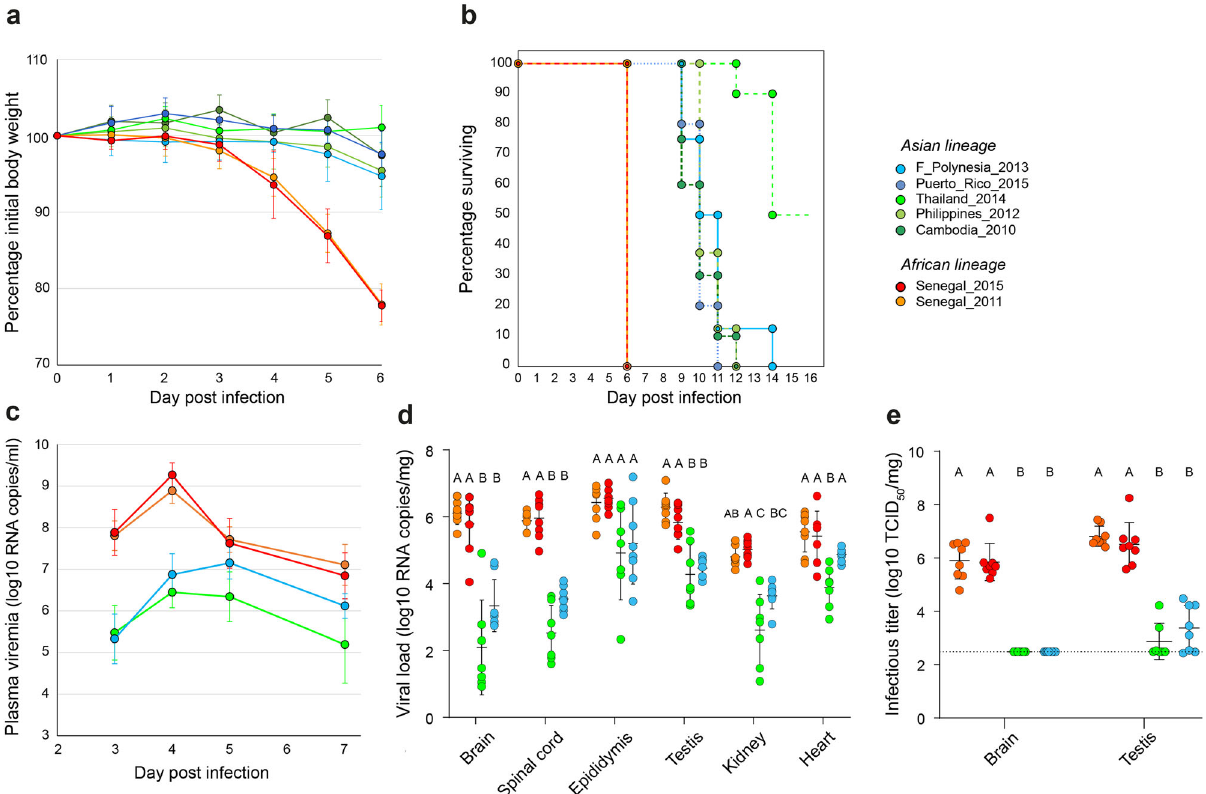
Fig. 4 Pathogenicity of African and Asian ZIKV strains in immunocompromised adult mice. In a fi rst experiment ( a , b ), male AG129 mice were inoculated with 10 3 PFU of ZIKV. Each virus strain was represented by n = 10 mice, with the exception of the F_Polynesia_2013 and Philippines_2012 strains that were represented by n = 8 mice. a Mouse weight over time is shown as the percentage of body weight prior to infection (mean ± standard error). b Mouse survival over time is shown as the percentage of mice alive. Mice were euthanized when reaching humane endpoints (weight loss >20% or/and severe symptom onset). In a second experiment ( c – e ), male AG129 mice were inoculated with 1 PFU of ZIKV ( n = 8 mice per strain). c Time course of mouse viremia is shown in log 10 -transformed viral genome copies per ml of plasma (mean ± standard error). Three extreme outliers were excluded for the Senegal_2015 strain. d Viral loads in organs collected on day 7 post infection are shown in log 10 -transformed viral genome copies per mg of tissue. Statistical signi fi cance of differences was determined by one-way ANOVA followed by Tukey ’ s post hoc test for brain, heart and testis, by Brown – Forsythe and Welch ANOVA followed by Games-Howell ’ s post hoc test (two sided) for epididymis and spinal cord, and by Kruskal – Wallis rank-sum test followed by Dunn ’ s post hoc test (two sided) for kidney. Viral loads were signi fi cantly higher for African than for Asian ZIKV strains in the brain ( p < 0.0001), spinal cord ( p < 0.0001), testis ( p < 0.0001), kidney ( p < 0.0001), and heart ( p < 0.0001). e Infectious virus in brain and testis collected on day 7 post infection are shown in log 10 -transformed 50% tissue-culture infectious dose (TCID 50 ) per mg of tissue. The horizontal dotted line indicates the lower limit of detection of the assay (310 TCID 50 units per mg of tissue). Statistical signi fi cance of differences was determined by Kruskal – Wallis rank- sum test followed by Steel-Dwass ’ s post hoc test for brain and by one-way ANOVA followed by Tukey ’ s post hoc test for testis. Infectious titers were signi fi cantly higher for African than for Asian ZIKV strains in the brain ( p < 0.0001) and testis ( p < 0.0001). In ( d , e ), data are presented as mean ± standard deviation and ZIKV strains not sharing a letter above the graph are statistically signi fi cantly different ( p < 0.05). Source data are provided as a Source Data fi